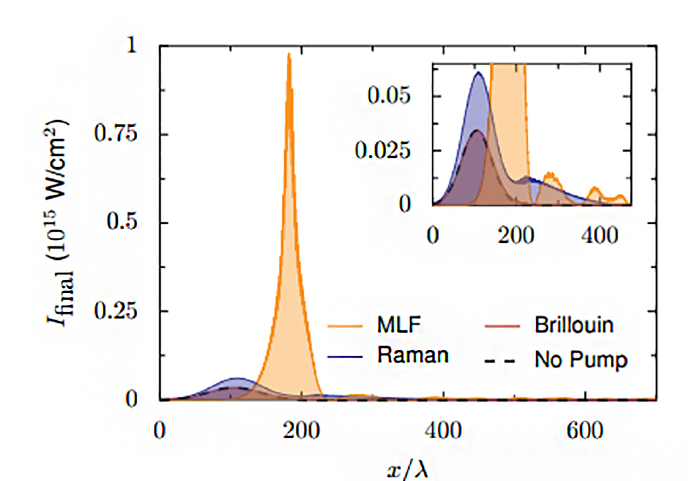
Figure 7. Final amplified seed after interaction in a plasma with N = 0.01, L = 175 λ ) with a counter-propagating pump ( a 0 = 0.007, λ = 1 µ m, and I = 6.7 × 10 13 W/cm 2 . This figure was reprinted/adapted with permission from Ref. [188]. Copyright year: 2022, Publisher: American Physical